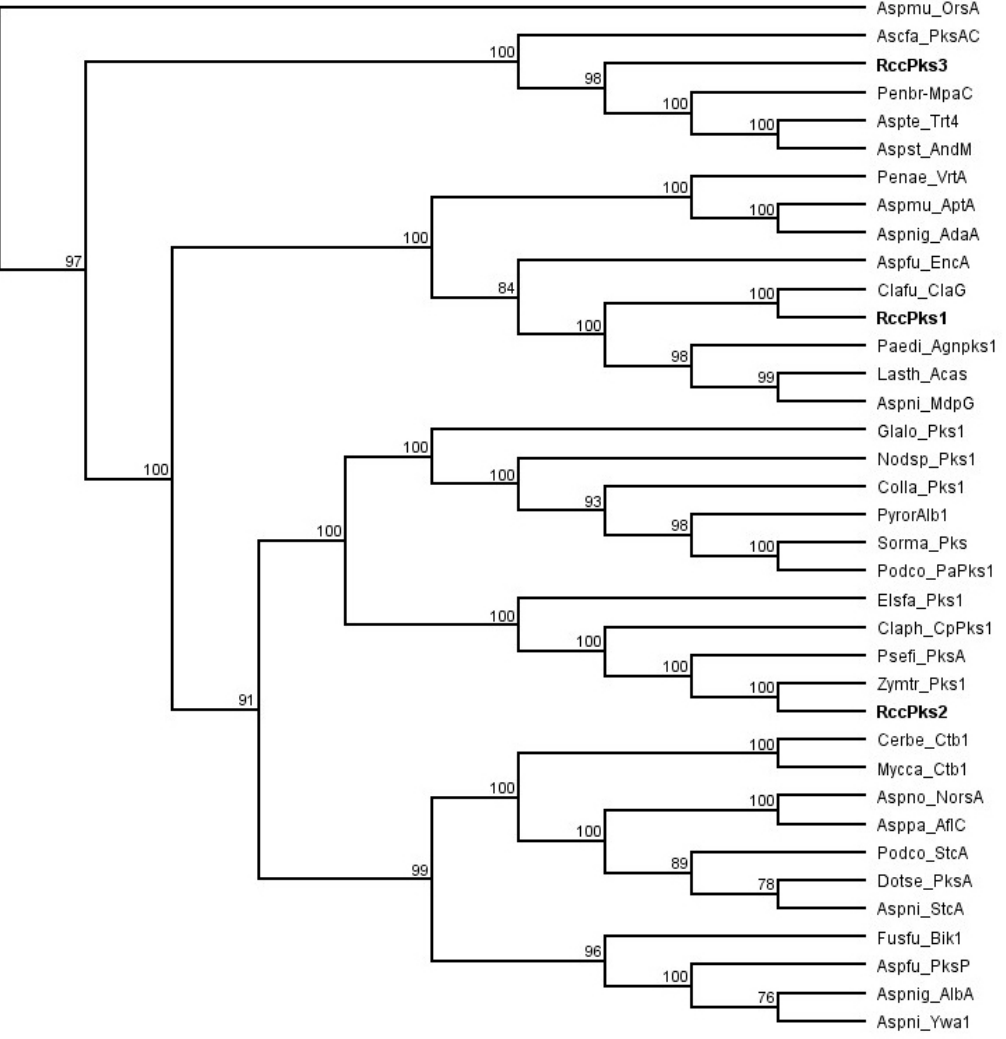
Figure 2. Phylogenetic analysis of R. collo-cygni nonreducing polyketide synthases (NR-PKSs). The cladogram was obtained using maximum likelihood on full-length protein sequences with 100 replications and nodal support value cutoff set at 75%. The list of sequences used in this study can be found in Supplementary information Table S1.